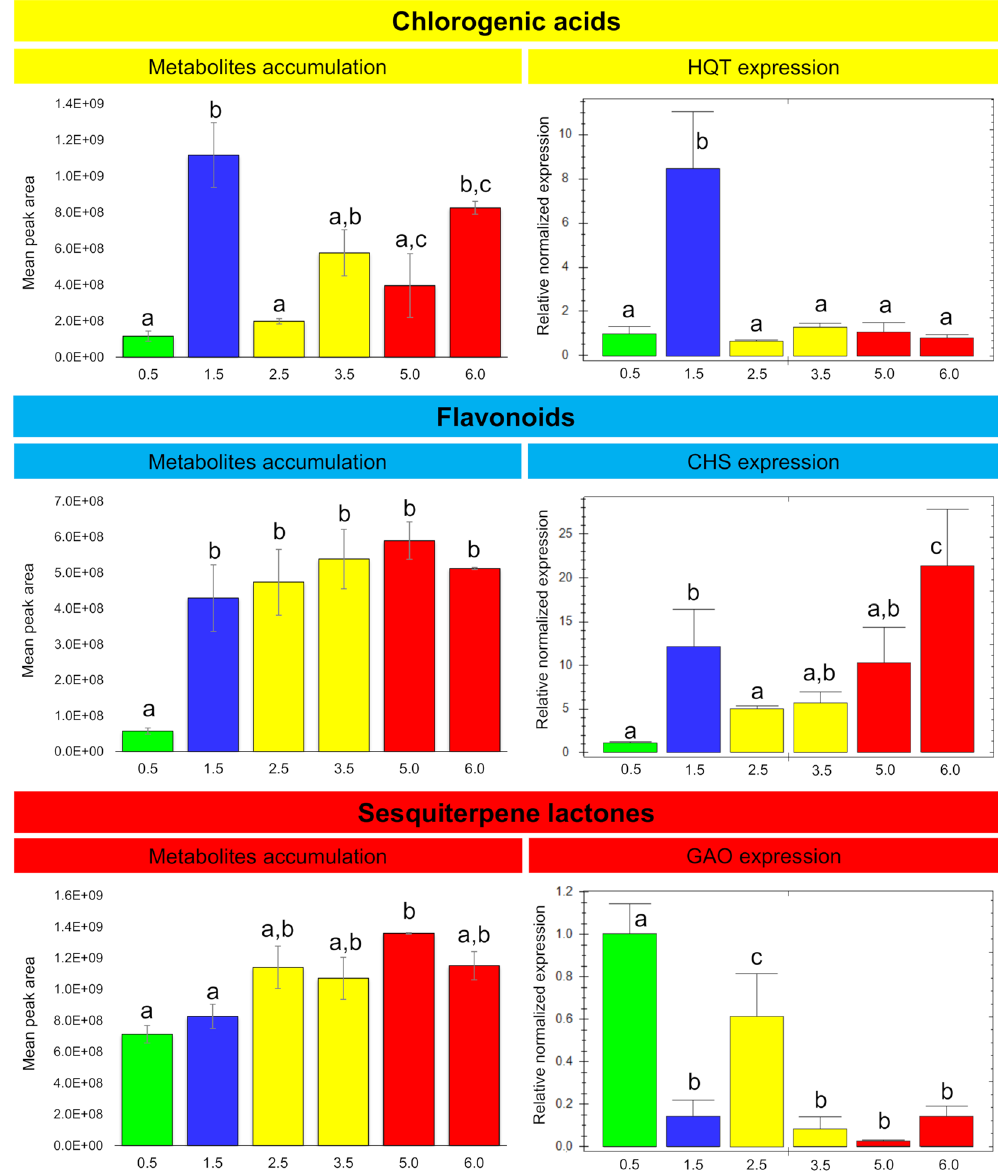
Figure 5. Accumulation of chlorogenic acids (8, 9, 15–17), flavonoids (22–28) and sesquiterpene lactones (29–38) and gene expression of HQT, CHS and GAO during yacón development. Leaf samples collected from 0.5 to 6-months-old plants. Metabolite identities reported in Fig. 3. Normalized gene expression is given relative to the youngest stage and housekeeping genes ACT and EF (n = 3). Error bar: SEM. HQT: hydroxycinnamoyl CoA: quinate hydroxycinnamoyl transferase; CHS: chalcone synthase; GAO: germacrene A oxidase; ACT: actin; EF: elongation factor 1a. Bars colored according to the HCAbp groups (Group 1: green; group 2: blue; group 3: yellow and group 4: red). Same letters into the bar graphs do not differ